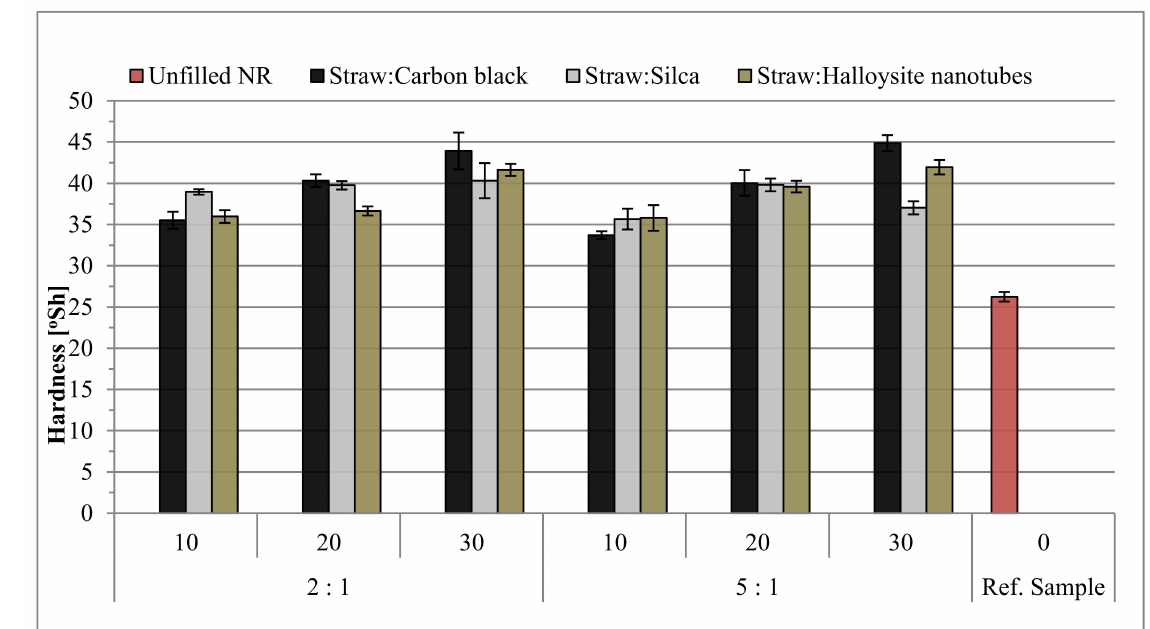
Figure 16. The hardness results of rubber